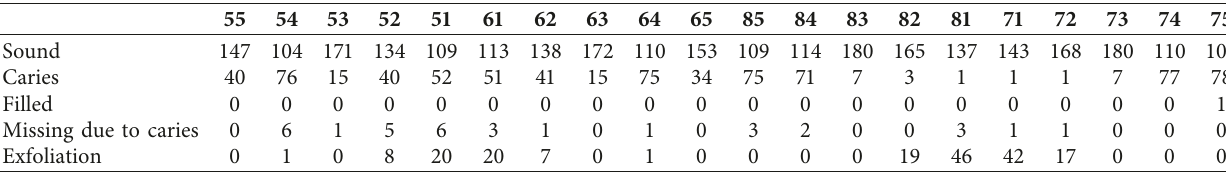
Figure 1: Distribution of dmf of the 187 Myanmar children aged 5 and 6. Even though the mode was 0, 152 (81.3%) subjects had at least one def tooth. The mean ± SD and median and 25th to 75th percentile were 4.26 ± 3.76 and 4 (1–7), respectively. Table 1: Tooth-level distribution of dental caries in primary